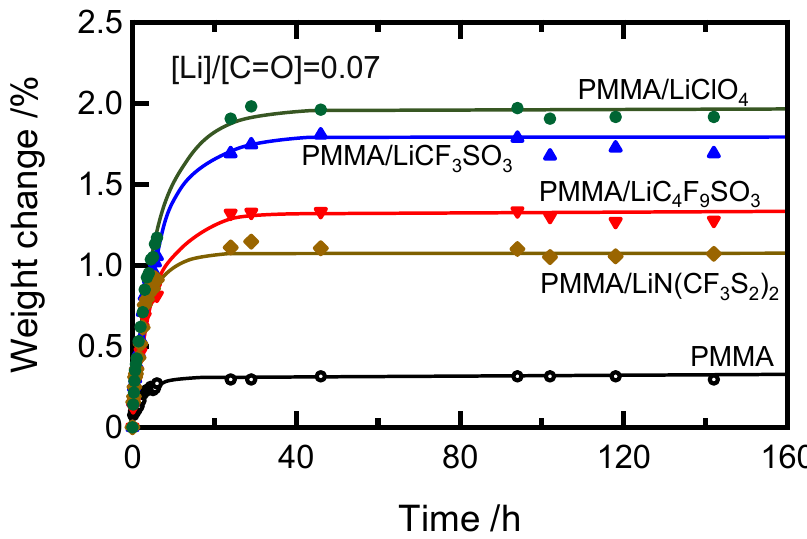
Figure 5. Weight changes in PMMA doped with LiClO 4 , LiCF 3 SO 3 , LiC 4 F 9 SO 3 , and LiN(CF 3 SO 2 ) at 23 °C and 70% RH.